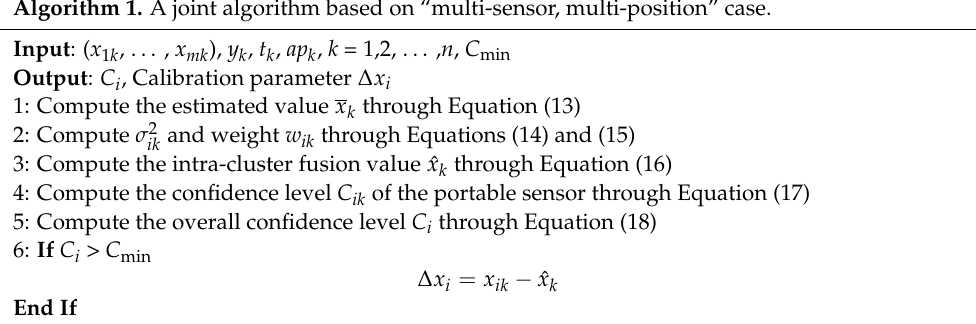
Algorithm 1. A joint algorithm based on “multi-sensor, multi-position”